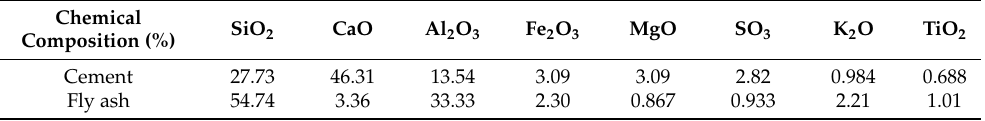
Table 2. Main chemical composition of binder